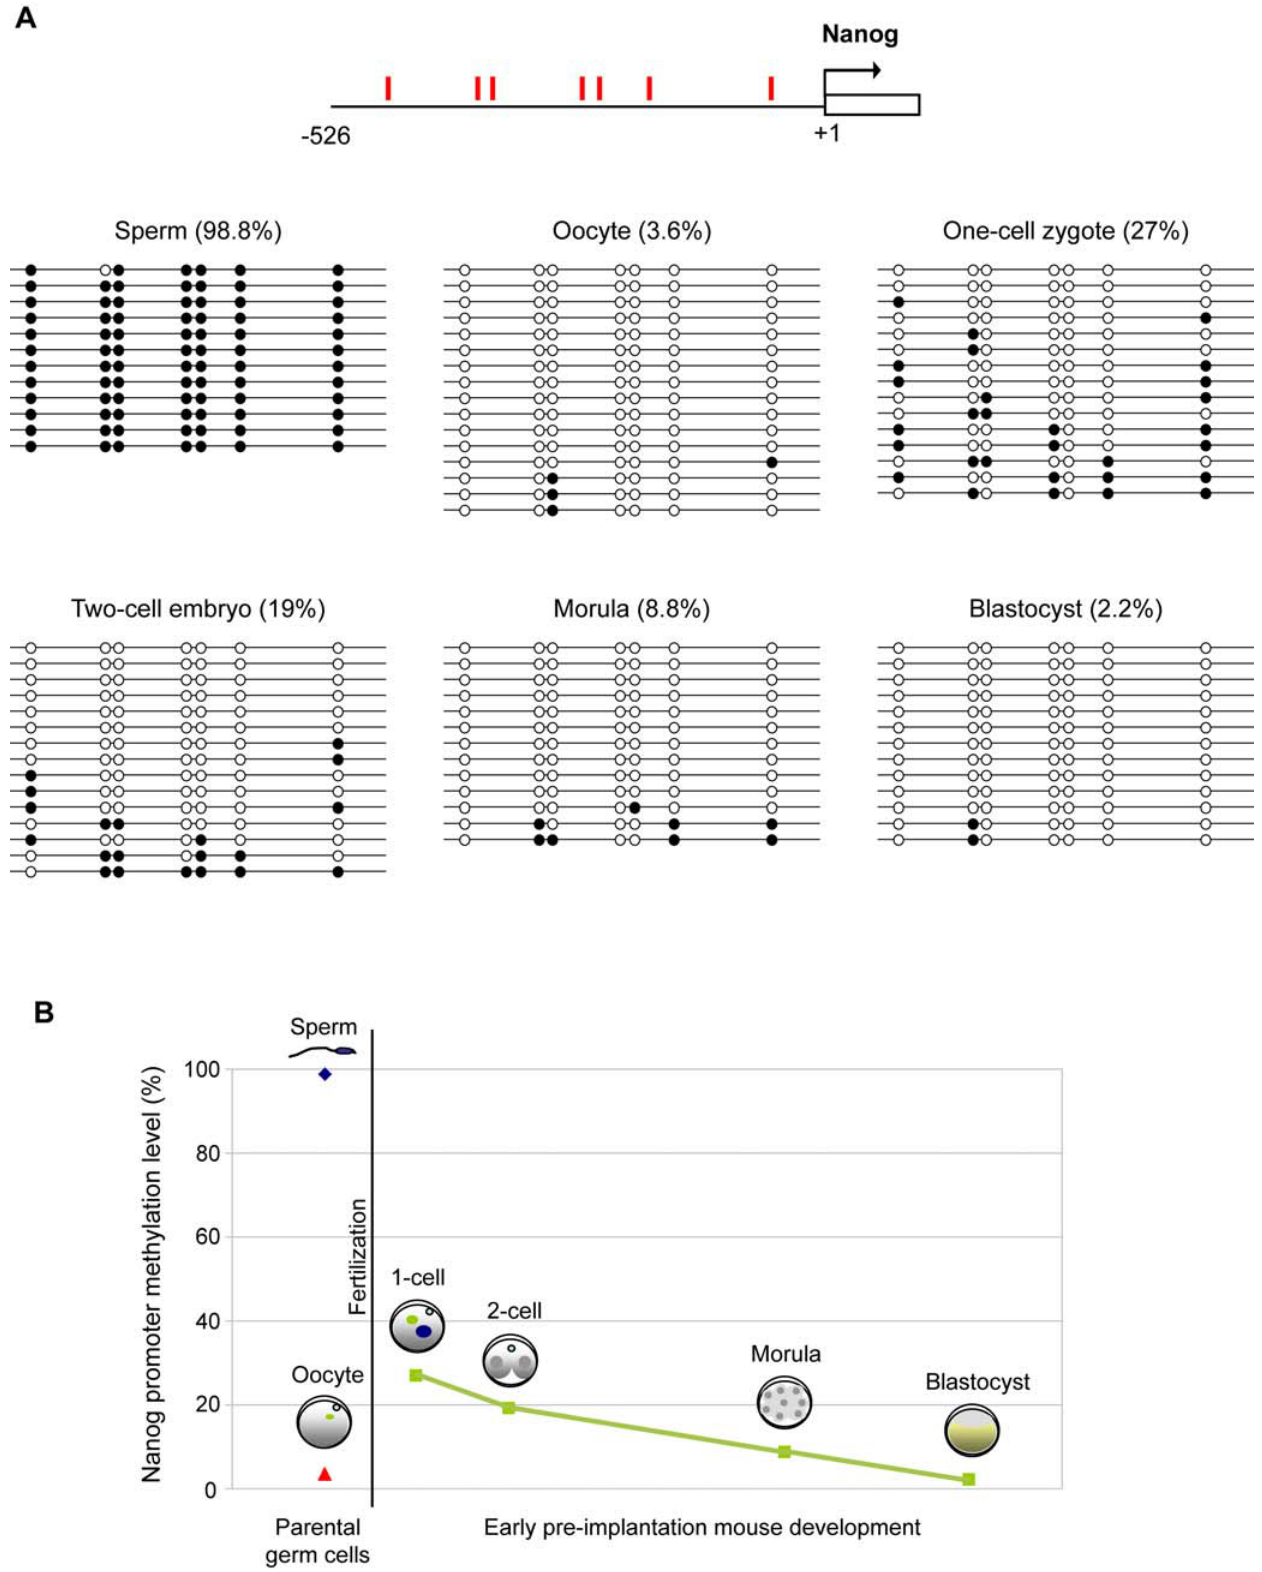
Figure 6. Epigenetic reprogramming of the Nanog promoter during preimplantation development. (A) Methylation patterns of the Nanog promoter in gametes and in early fertilised embryos were determined by bisulphite sequencing analysis. The Nanog promoter is highly methylated in sperm but hypomethylated in fertilised embryos. CpG dinucleotides are represented as open circles (unmethylated) or closed circles